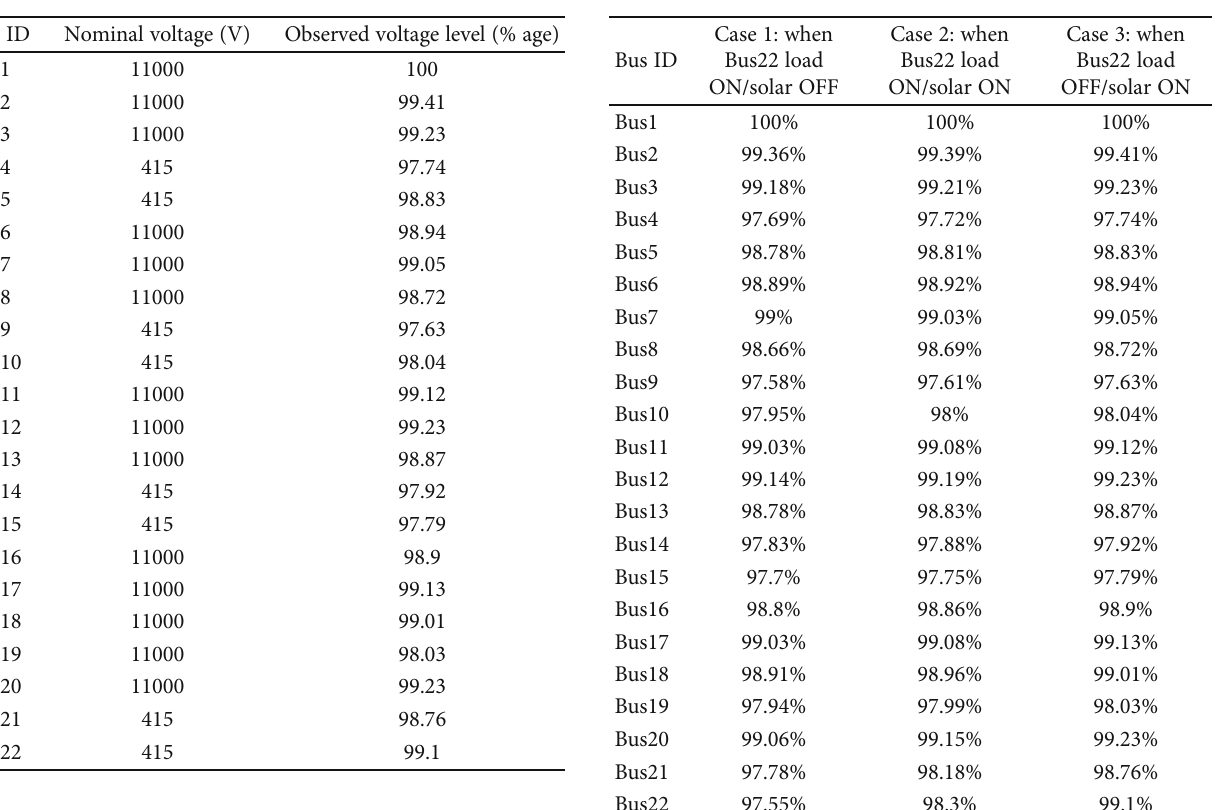
Table 11: Voltage pro fi le in Case 3.